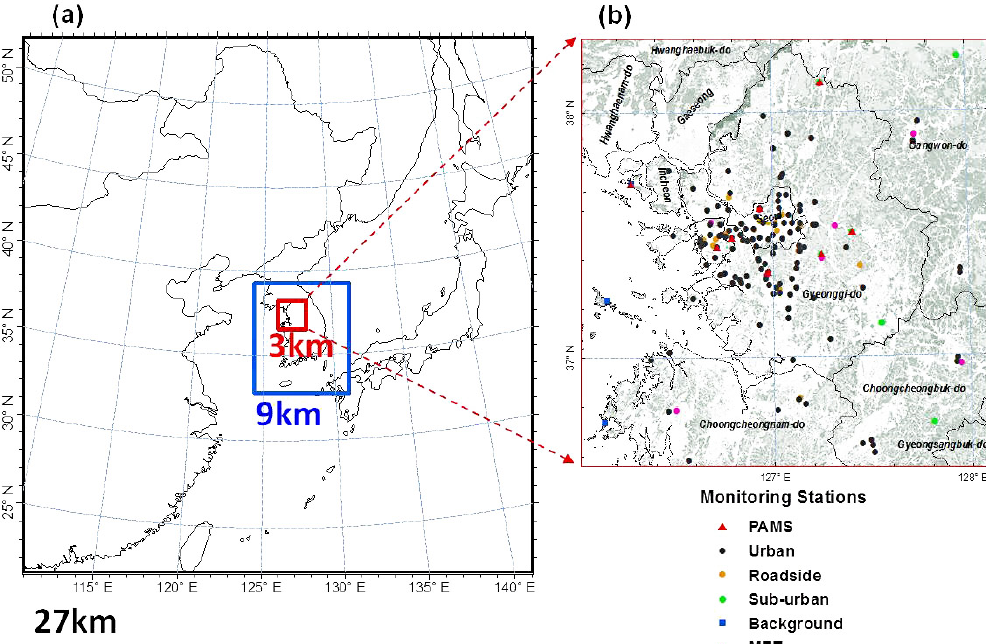
Figure 1. The modeling domain. The target domain is a 3km × 3km grid system domain covering the Seoul, Gyeonggi, and Incheon Metropolitan Areas. Note that “27km”, “9km”, and “3km” refer to the model grid resolutions.